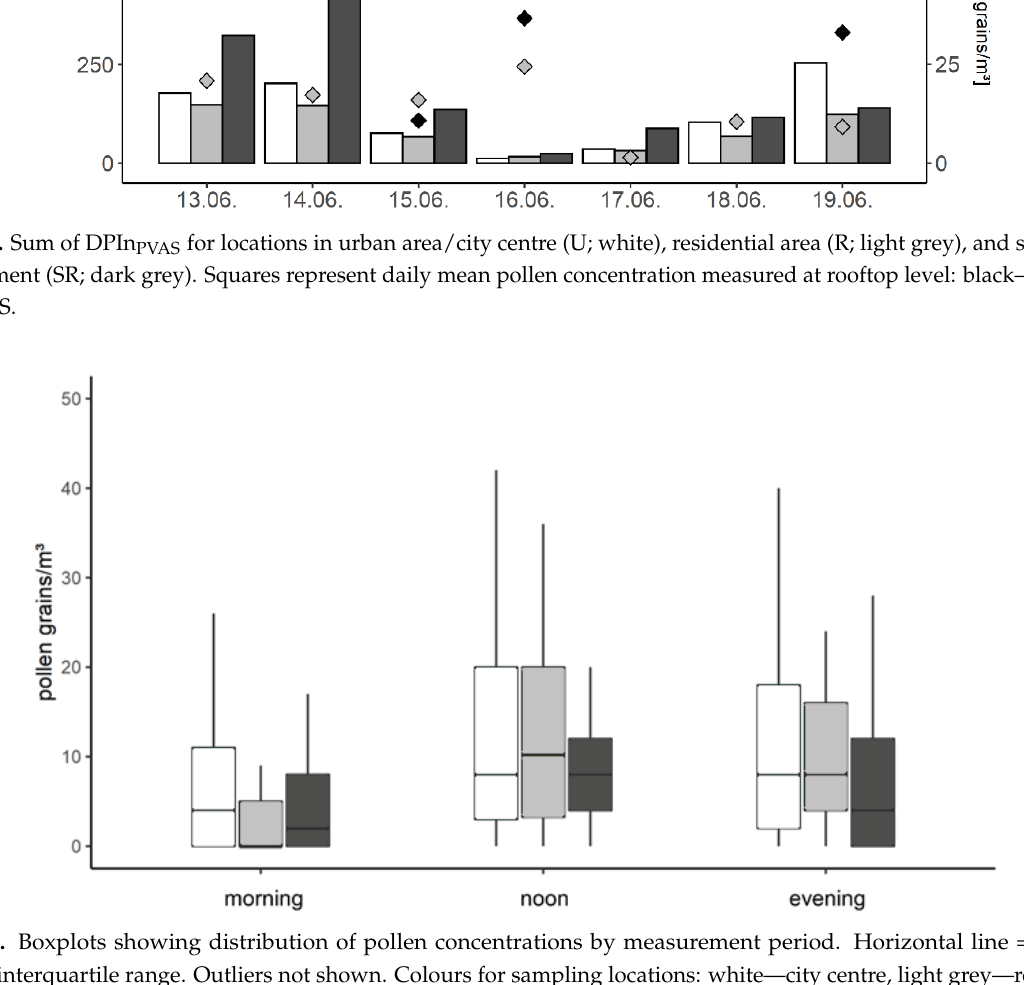
Figure 9. Diurnal pattern of Poaceae pollen concentration recorded by both 7-day volumetric traps, grey—US, black—SRS ( a ) during 2019; ( b ) during the week of PVAS sampling (13 June–19 June 2019). 3.3.3. Land Use Land use surrounding the traps varied depending on locations (Table 2). Based on grassland data (European Union 2020), areas covered with grass within 100 m were found in 7 out of 11 locations: U2 (1%), U4 (15%), R3 (6%), SR1 (10%), SR2 (15%), SR3 (48%), and SR4 (11%). Based on land cover classification 2019 [43], areas defined as low vegetation could be found in the surroundings of at all sites except U3; agricultural areas were present at sites SR1 (20%), SR2 (47%), SR3 (46%), and SR4 (42%). We found no statistically significant relationship between CPIn PVAS and the percentage of agricultural area, grass cover, low vegetation, or Urban Index.